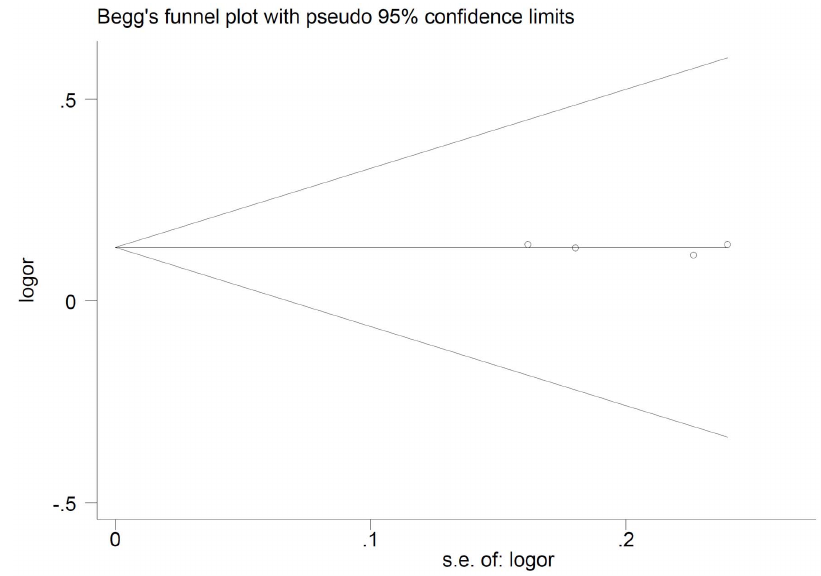
Figure 6. Begg’s funnel plot of MAP3K1 rs16886165 polymorphism and breast cancer risk.